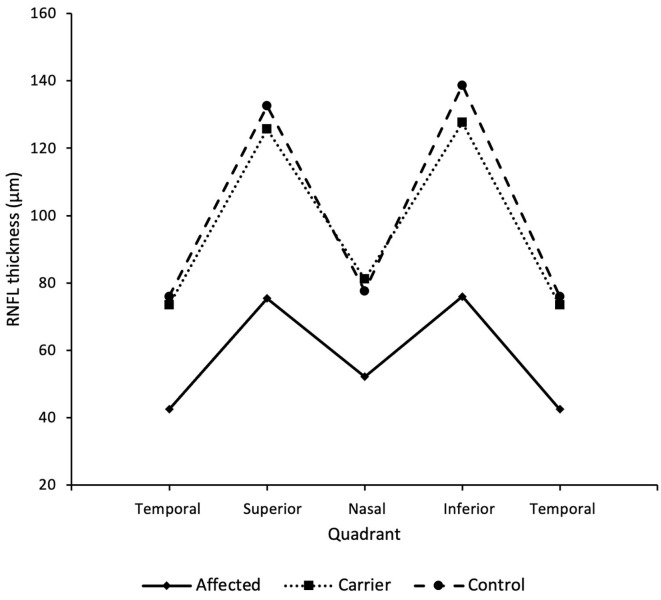
RNFL thickness in each quadrant of LHON affected, LHON asymptomatic carriers and controls, showing a significantly thinner RNFL in all quadrants for LHON affected compared to carriers and controls (p < 0.0001).